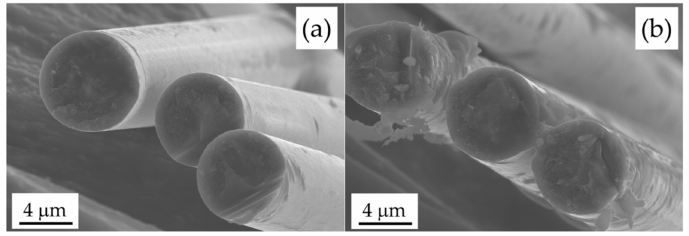
Figure 9. FE-SEM images of rCF-500 ( a ) and rCF-500 ( b ), which were MW-irradiated for 5 min and washed with ethanol to remove unreacted epoxy